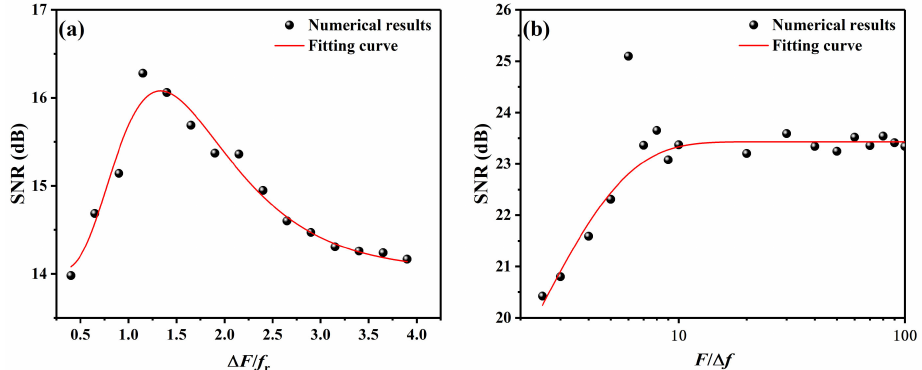
Figure 8. Effects of frequency sweeping ( a ) range ∆ F and ( b ) step ∆ f on